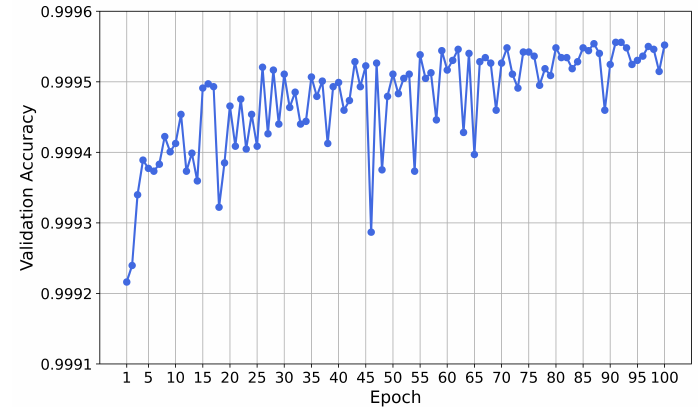
Figure 10. Validation accuracy of the neural network for each